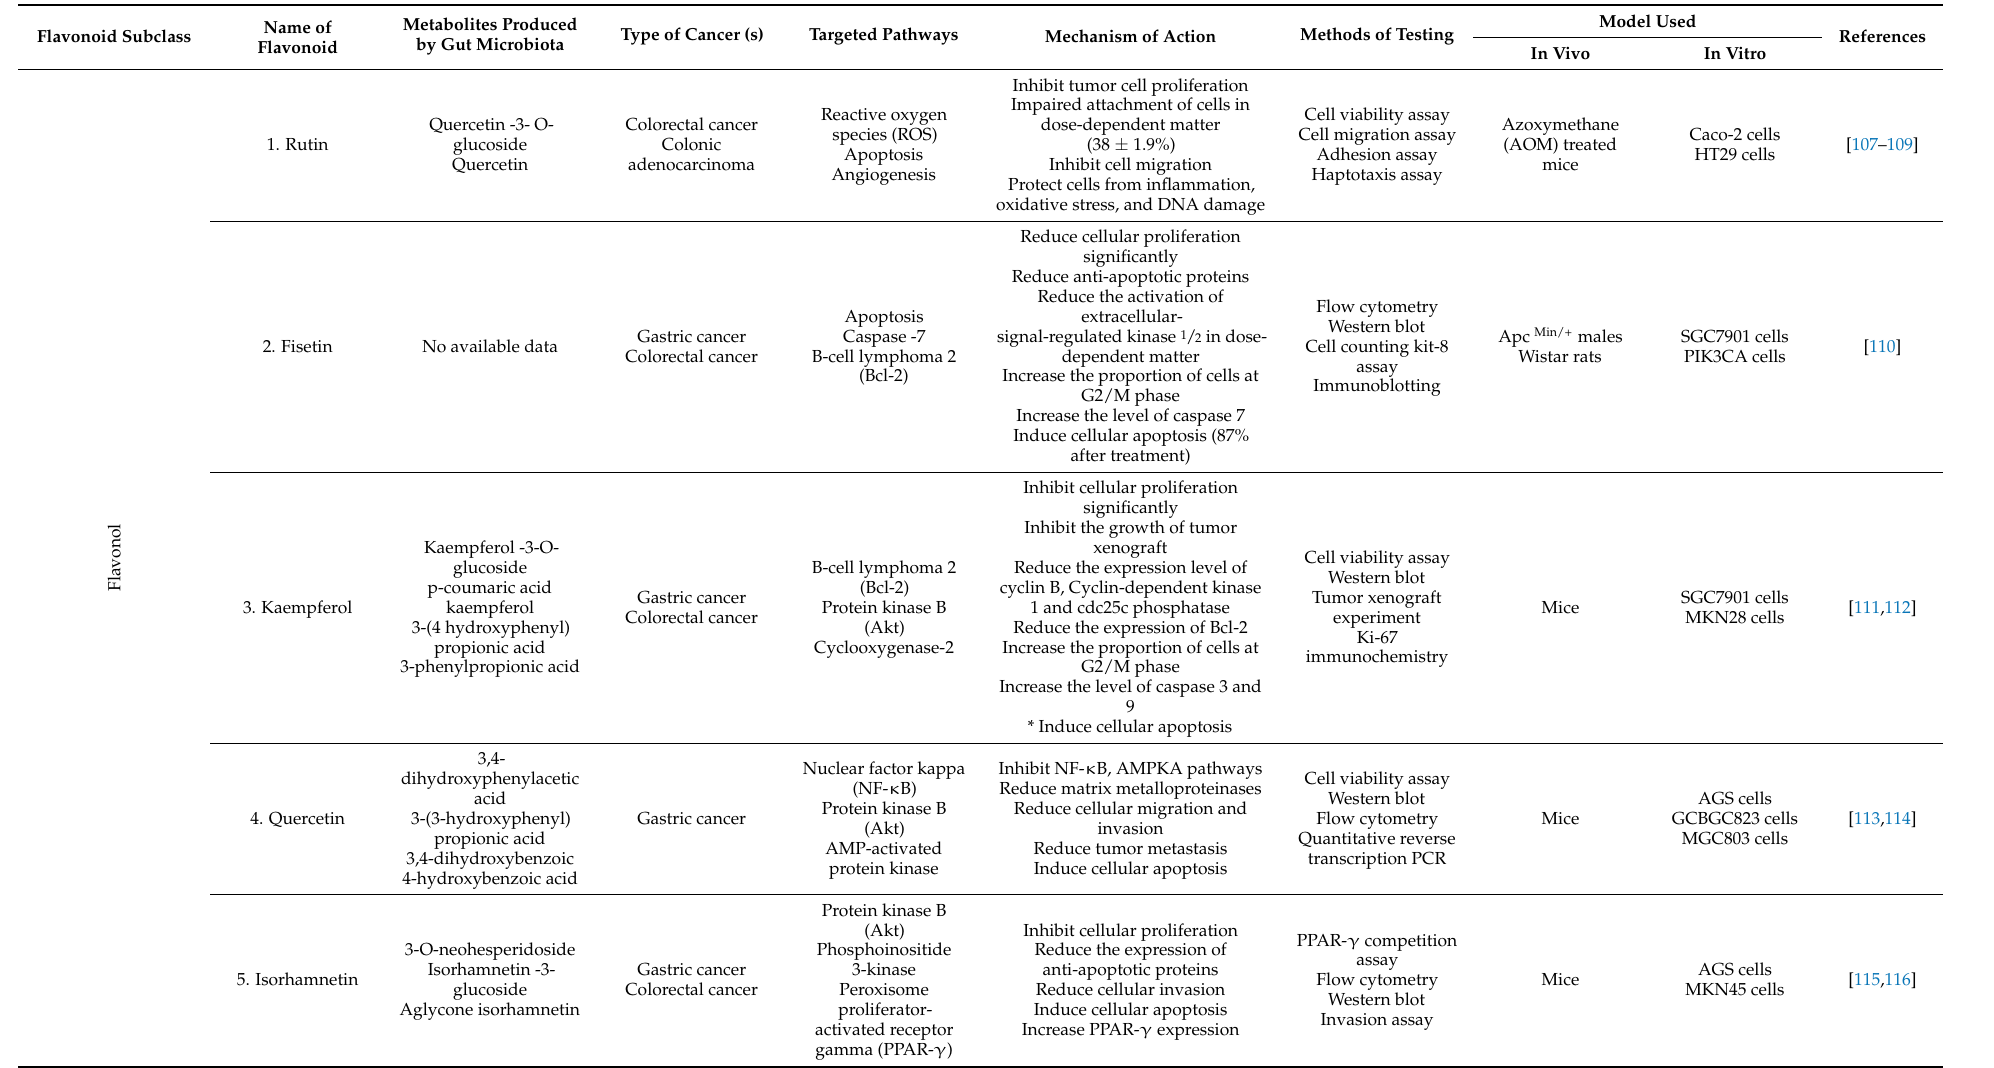
Table 2. Representative Flavonoids and their Underlying Anticancer